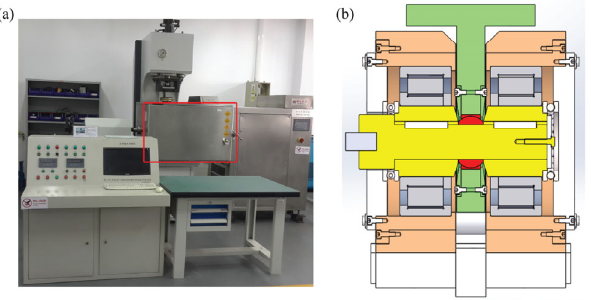
Fig. 9 Physical diagram and schematic diagram of swinging wear test of self-lubricating spherical plain bearing: (a) photograph of the swinging wear tester and (b) schematic diagram of loading